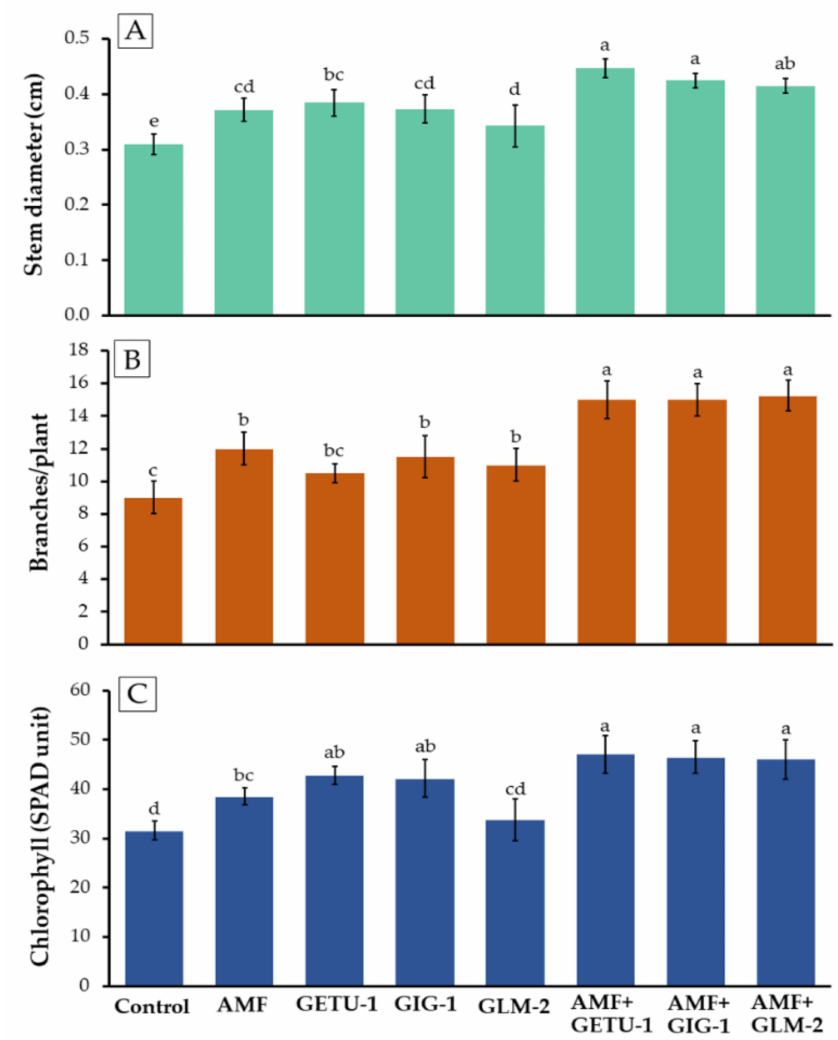
Figure 5. Stem diameter ( A ), branch per plant ( B ), and chlorophyll content in the leaf of chili plants ( C ) in each treatment at 180 days. The means with the standard deviation bar are shown in each graph. Different letters above each graph in the same experiment indicate that the means are significantly different by DMRT ( p <